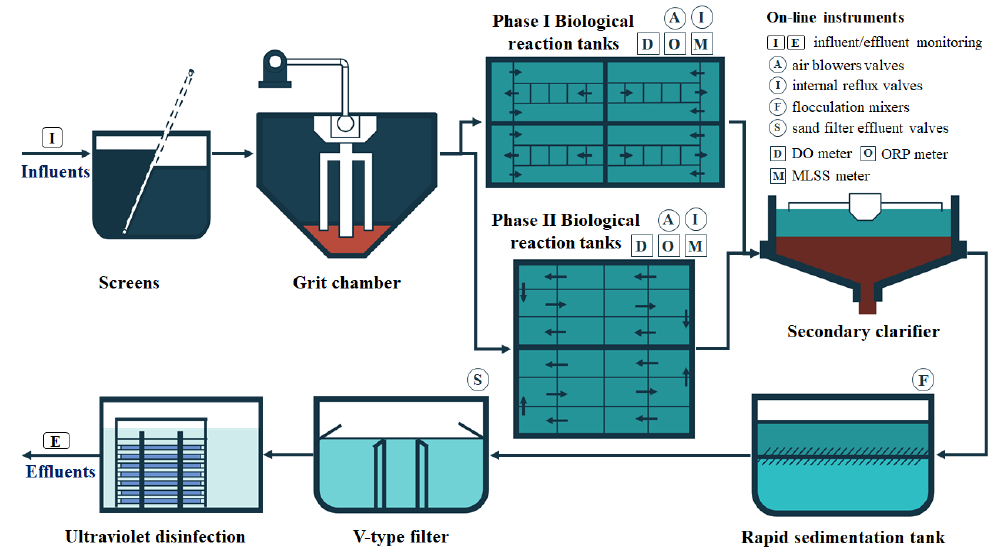
Figure 1. Schematic representation of treatment processes and on-line instruments in the selected WWTP.